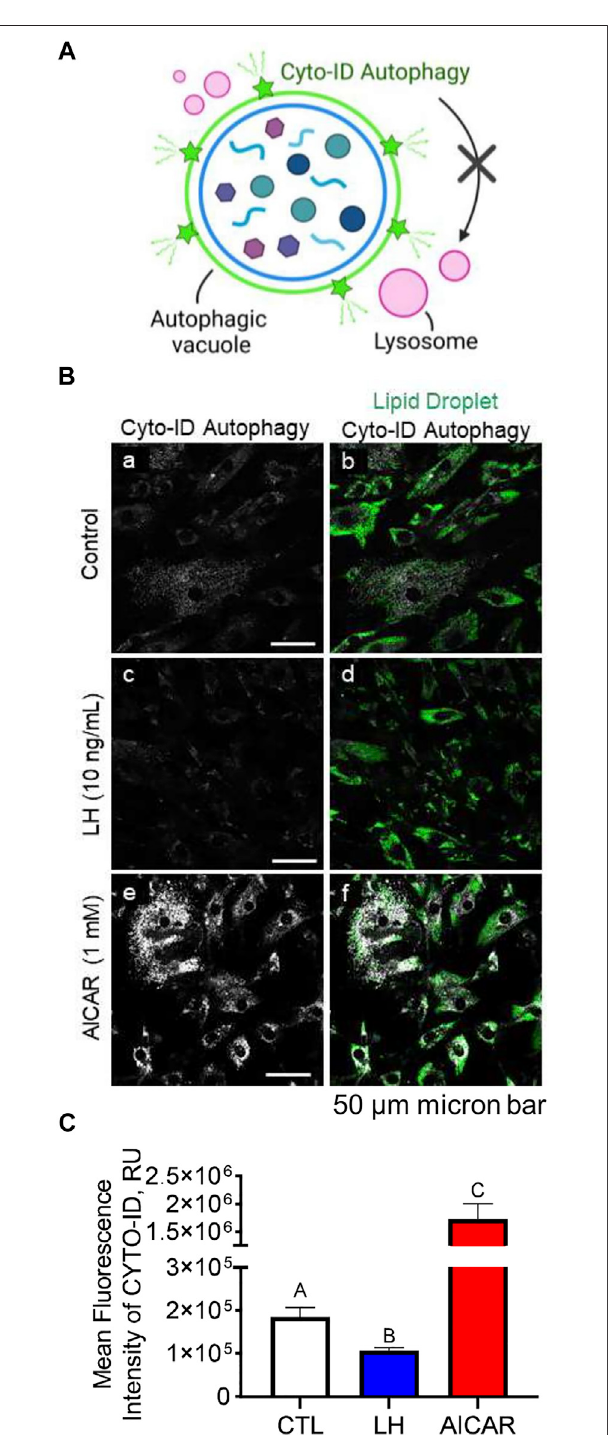
FIGURE 8 | Effects Luteinizing hormone (LH) and AICAR on autophagy in vitro . Luteal cells were stimulated with LH (10 ng/ml) or AICAR (1 mM) for 3 h and subject to confocal microscopy. (A) Illustration of Cyto-ID green detection reagentmechanismofaction. Cyto-IDisacationic amphiphilic tracerdyethatrapidlypartitionsintointracellularautophagicvacuoles.Thedye exhibits unique functional moieties that prevent accumulation within